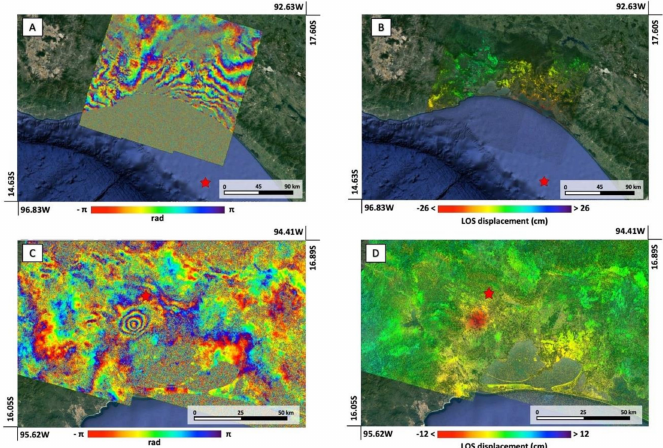
Figure 8. Sentinel-1 results relevant to the Mexico seismic events that occurred in September 2017. ( A ) Coseismic interferogram relevant to the Tres Picos earthquake produced from S1 descending images (Track 172) spanning the time interval 7 September 2017–13 September 2017. ( B ) Coseismic displacement map related to the interferogram reported in ( A ). ( C ) Coseismic interferogram relevant to the San Jer ó nimo Ixtepec earthquake produced from S1 descending images (Track 172) spanning the time interval 19 September 2017–25 September 2017. ( D ) Coseismic displacement map related to the interferogram reported in (C). The red stars identify the epicenters for the two (7 and 23 September) seismic